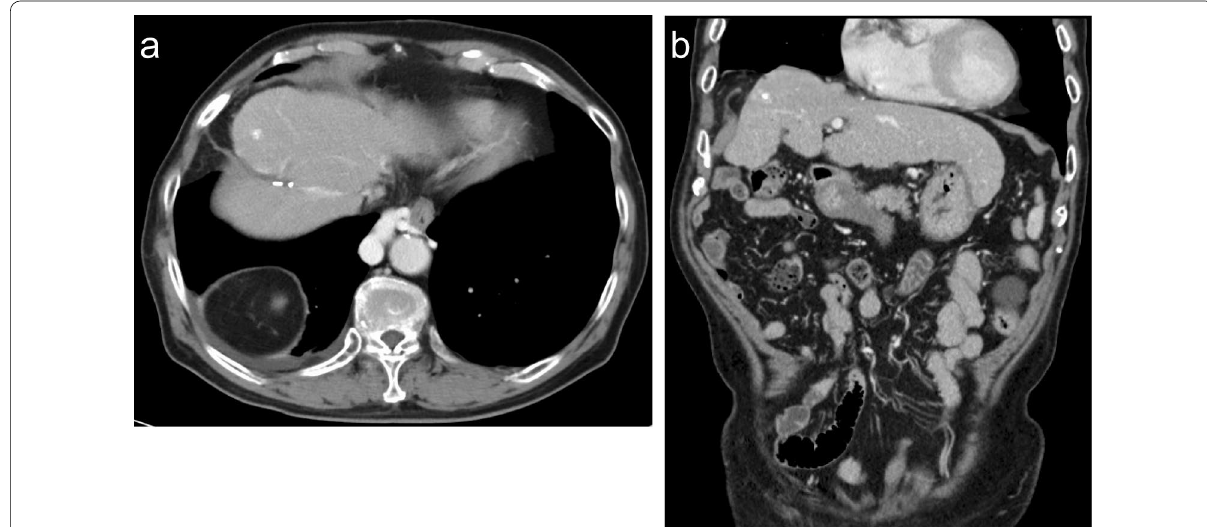
Fig. 5 CT image half a year before emergency surgery. a Axial view, b coronal view. There were no findings of diaphragmatic hernia or Chilaiditi